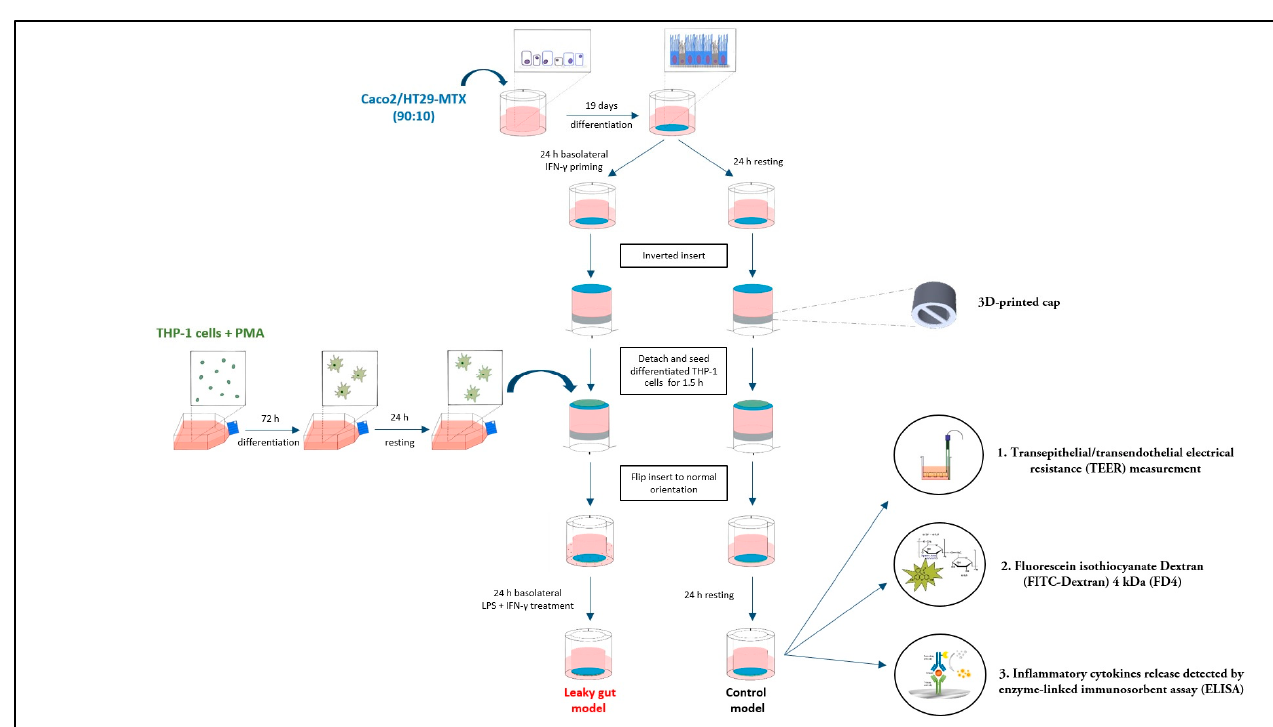
Figure 1. Schematic diagram of the in fl ammation-triggered, triple-culture in vitro “leaky gut” model. 19-day-di ff erentiated Caco-2/HT29-MTX-E12 co-cultures were either rested in fresh